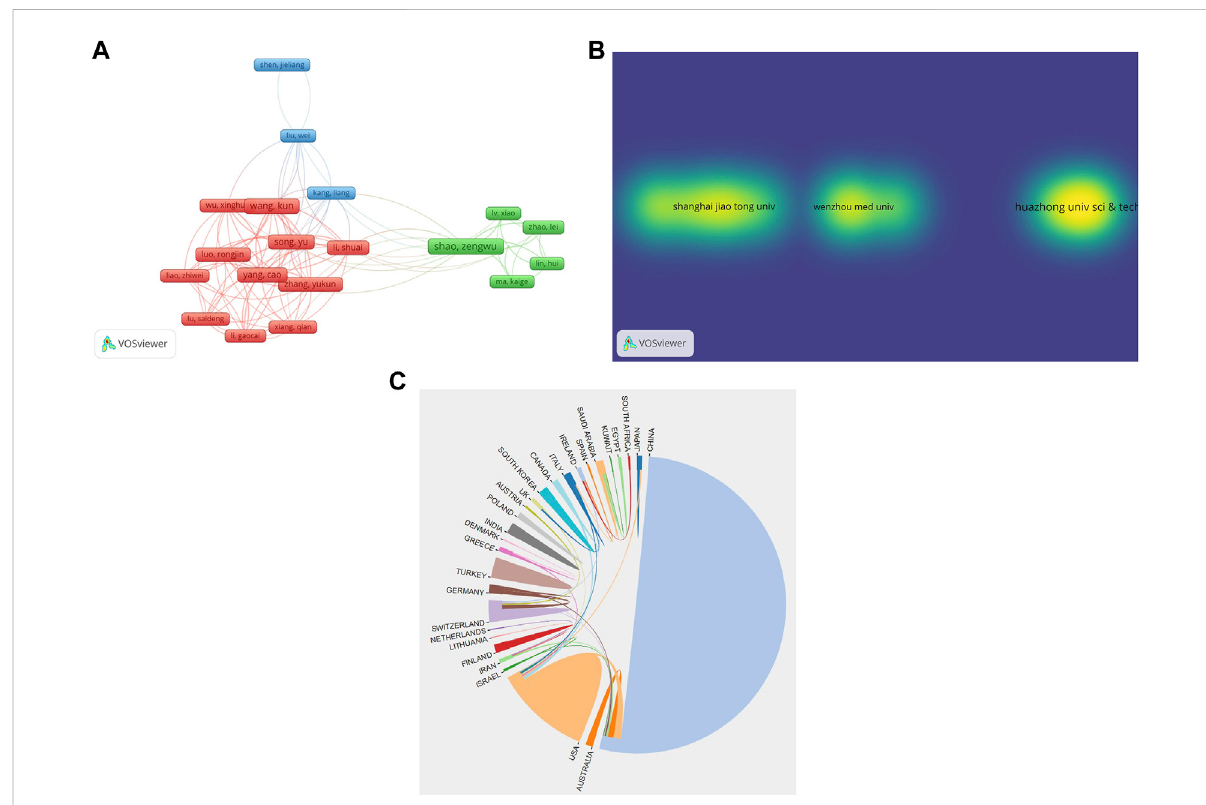
FIGURE 3 Theco-authorshipanalysisof (A) authors, (B) organizations,and (C) countriesonoxidativestressinintervertebraldiscdegeneration.(Thesizeof the frames represents the proportion of the author in the analysis. The larger the frames, the greater the contribution. The line between the frames representstheconnection betweentheauthors. Themoreorthickertheline,thestronger theconnection.Thecoloroftheareawhere